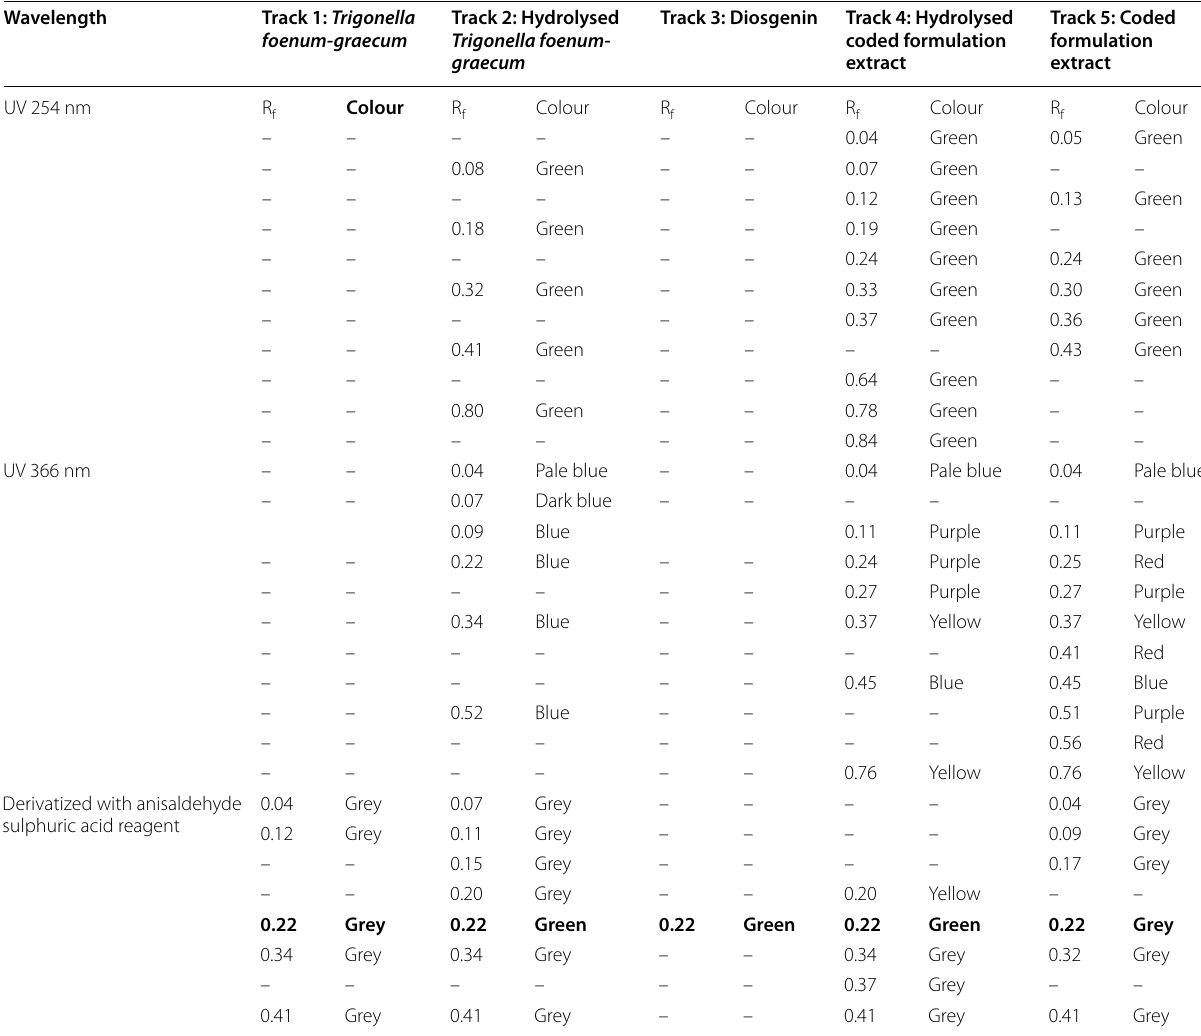
Table 1 R values of Trigonella foenum-graecum seeds, coded ayurvedic formulation, and Diosgenin reference standard f Wavelength Track 1: Trigonella